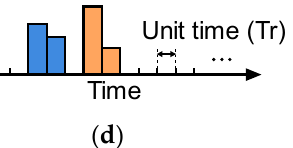
Figure 1. Separation of multi-path interference components: ( a ) optical setup that includes a transparent object causing multi-path interference, ( b ) compression of optical signals with temporal shutters, ( c ) compressed signals, and ( d ) reconstructed optical signal.